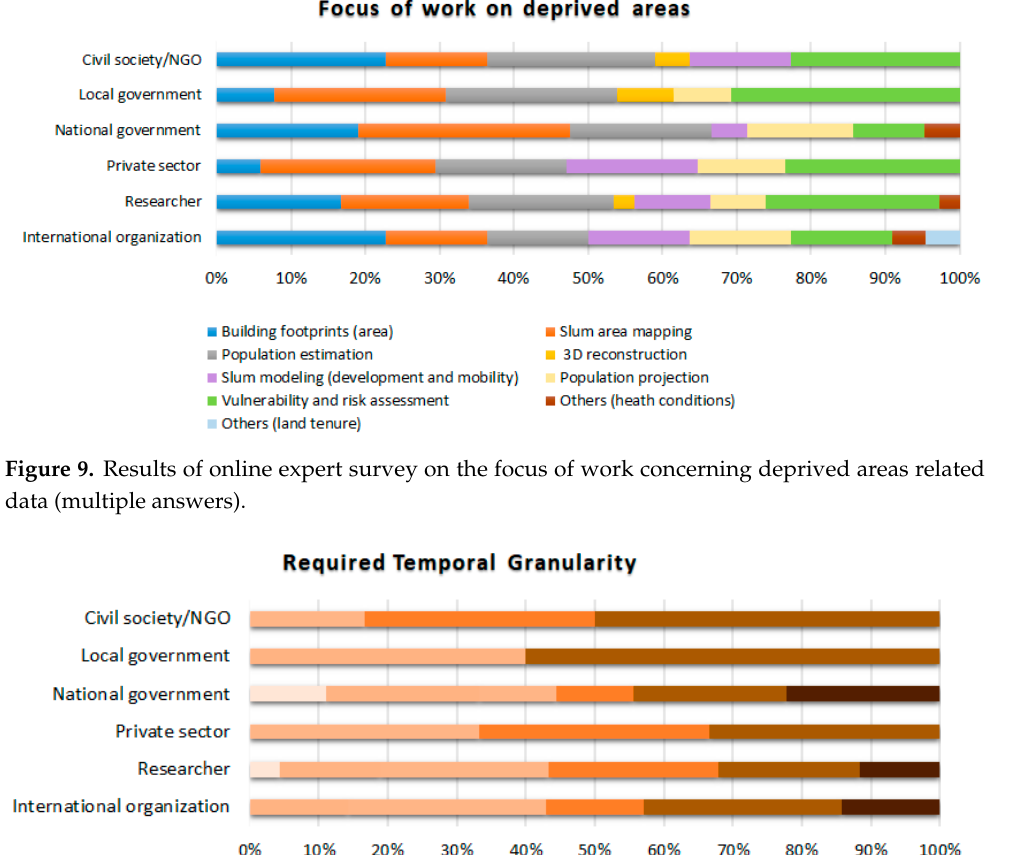
Figure 10. Results of online expert survey on the required temporal granularity of maps on deprived areas (in %) (N = 112).